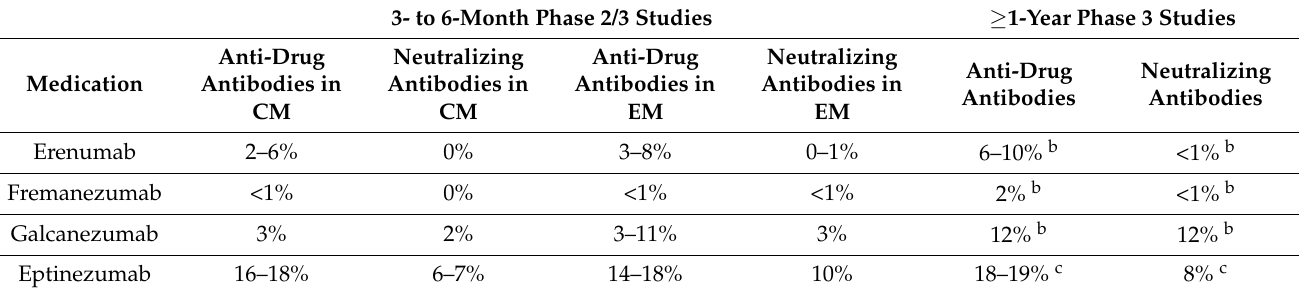
Table 2. Incidence of anti-drug antibodies and neutralizing antibodies a across phase 2/3 trials of monoclonal antibodies targeting the CGRP pathway [20–29,37–41,64,75]. 3- to 6-Month Phase 2/3 Studies ≥ 1-Year Phase 3